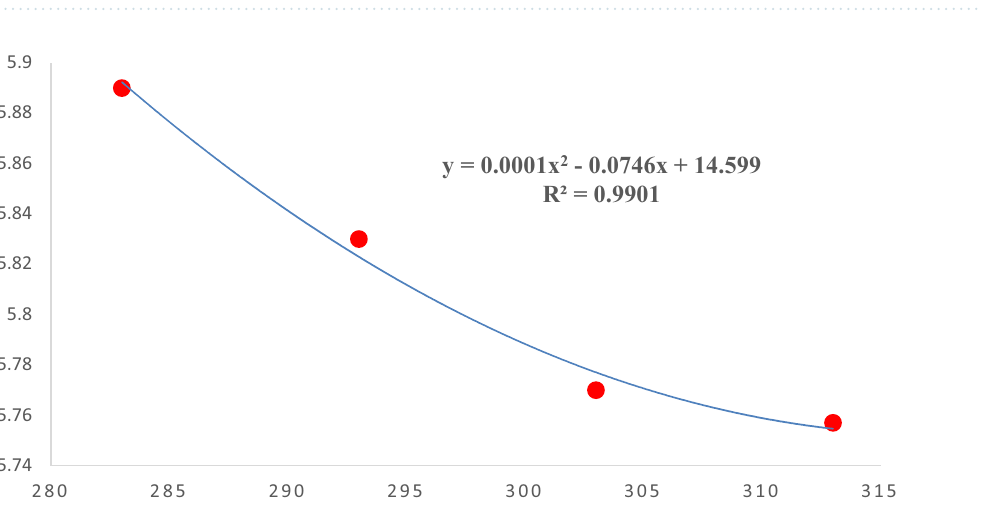
y = 0.0001x 2 - 0.0746x + 14.599